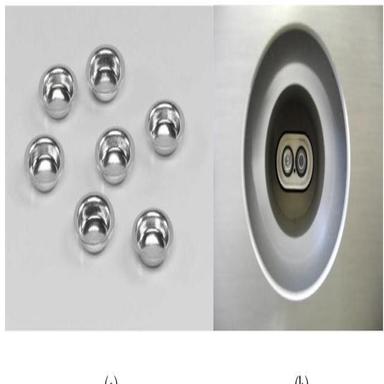
(a) DSC aluminum sample holders and (b) one sample placed in the DSC-oven.